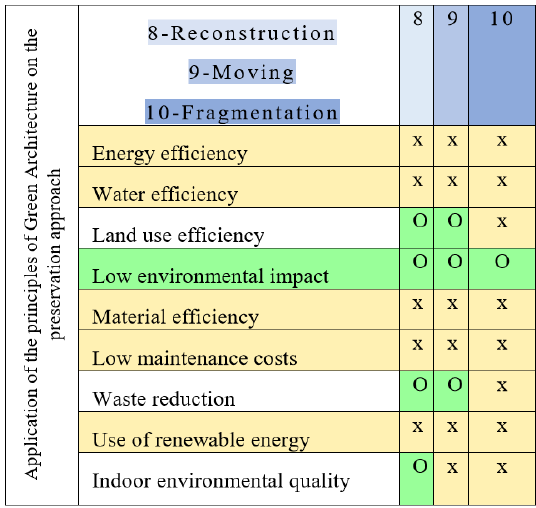
Table 3. Application of the principles of Green Architecture on the preservation approach: Reconstruction, Moving and